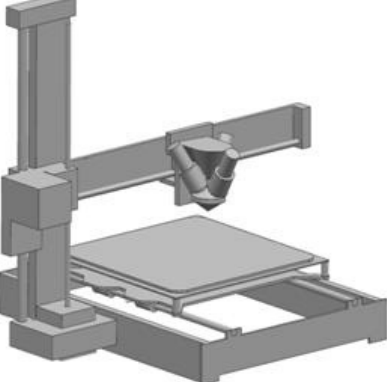
Figure 5. The color 3D printer model.